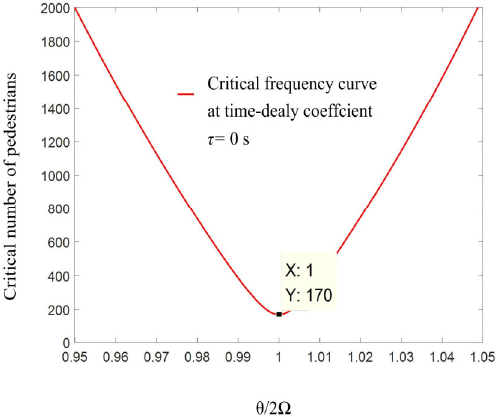
Figure 2. Relation curve between the midspan frequency ratio and critical pedestrian number (time-delay coefficient τ = 0 s).